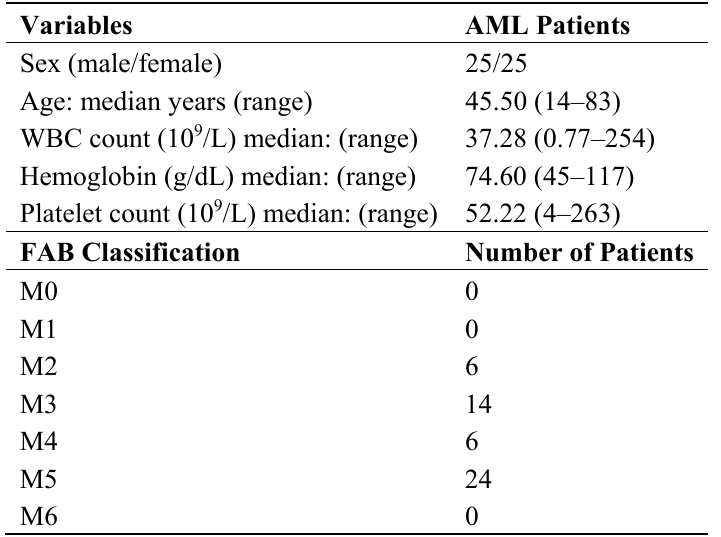
Table 1. Characteristics of the 50 AML